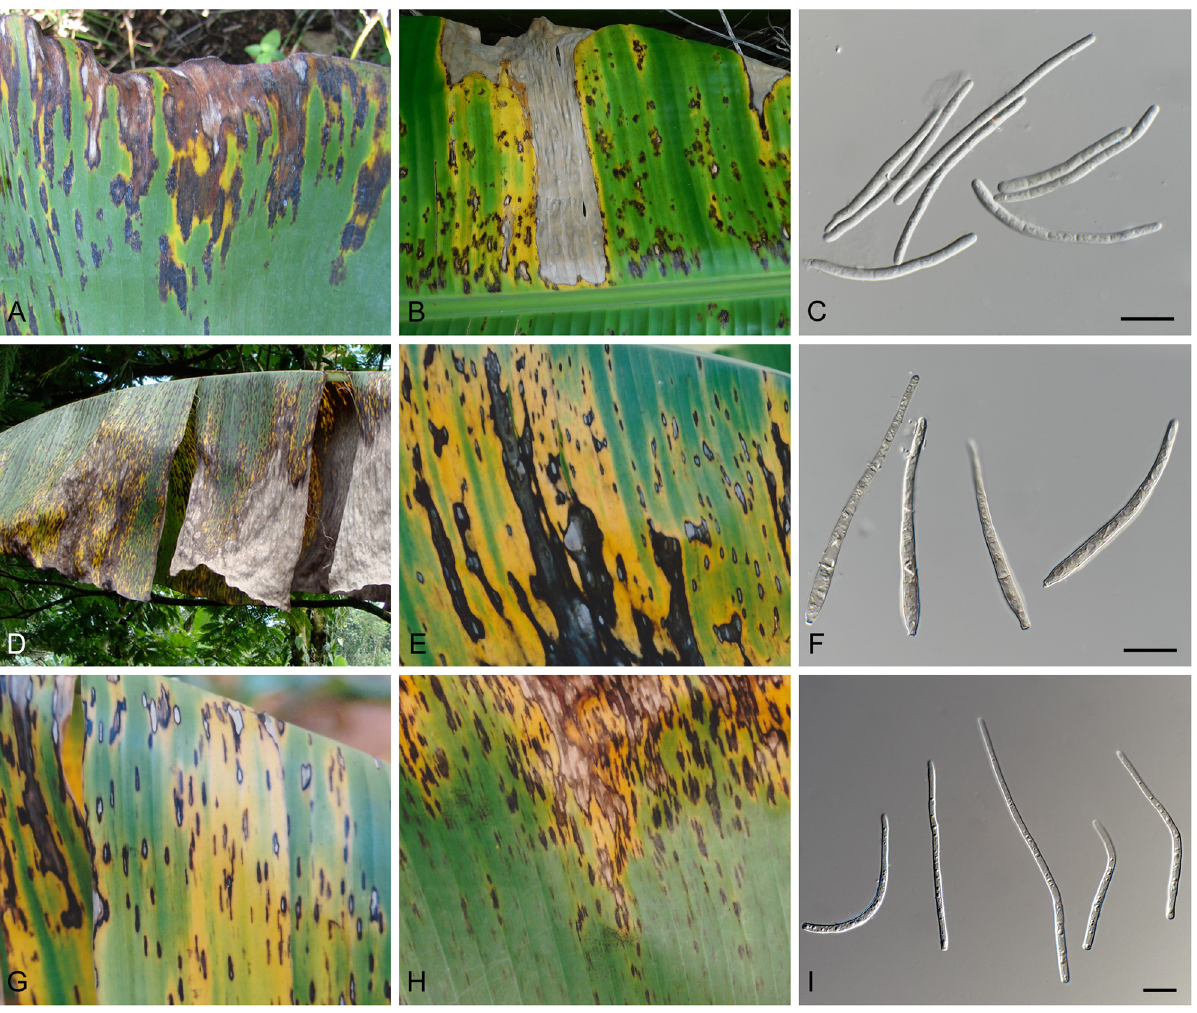
Fig 1. Disease symptoms caused on banana by the three species that constitute the Sigatoka disease complex. (A – C) Leaf symptoms and conidia of Pseudocercospora eumusae . (D – F) Leaf symptoms and conidia of Pseudocercospora fijiensis . (G – I) Leaf symptoms and conidia of Pseudocercospora musae . Scale bars = 10 μ m. (leaf photo credits Profs. A. Viljoen and G.